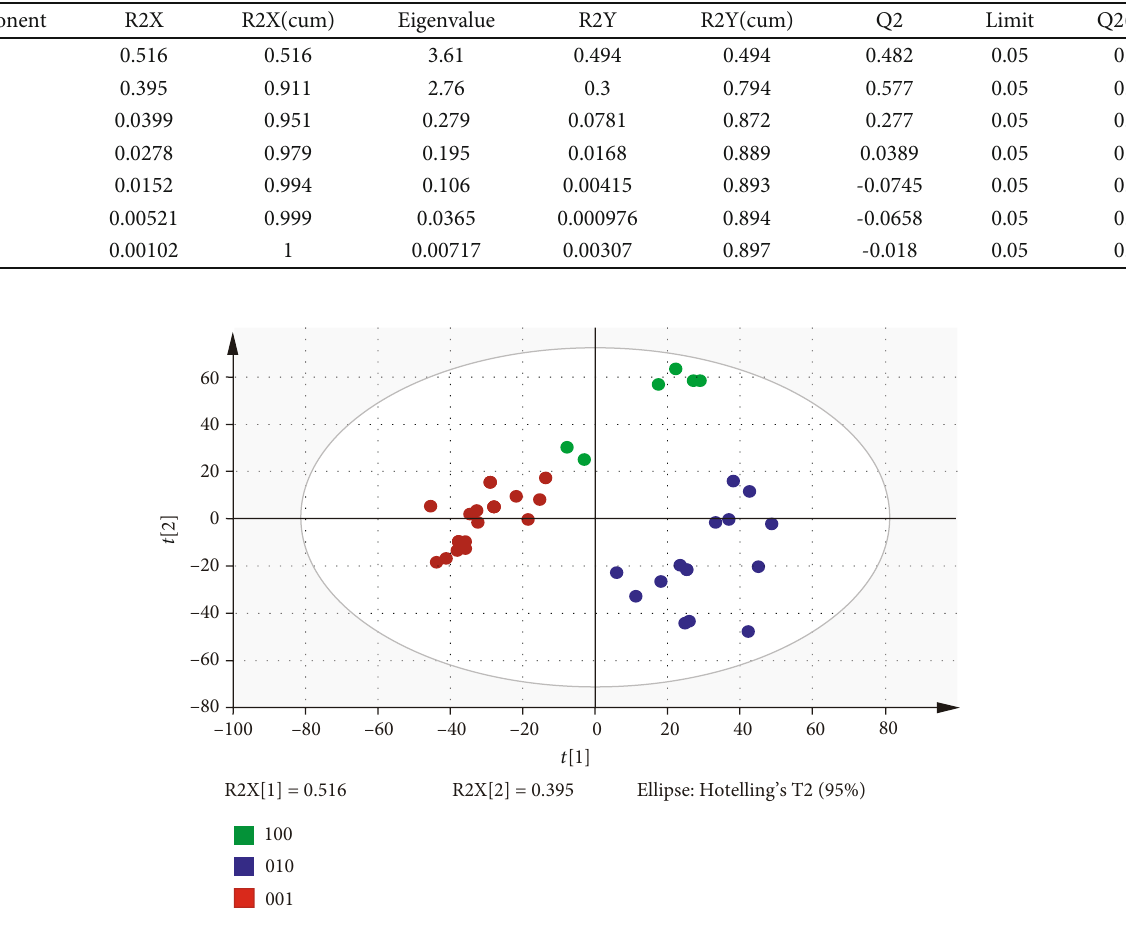
Figure 7: Score plot of PLS-DA. 100: fourth aquifer water; 010: coal-bearing sandstone aquifer water; 001: limestone aquifer